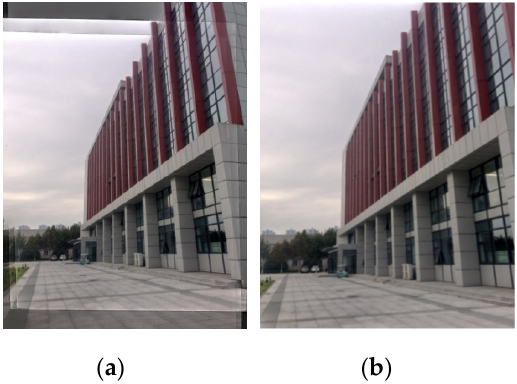
Figure 7. High-dynamic-range (HDR) fusion results. ( a ) Fusion result; ( b ) clipped result.